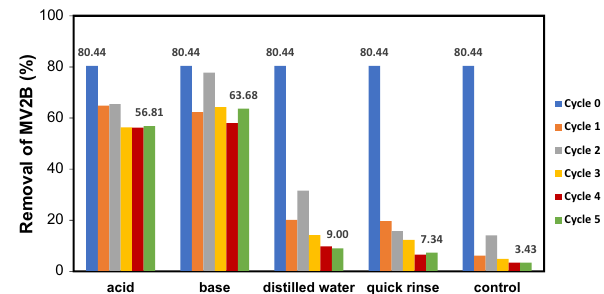
Fig. 7 Regeneration of IA through six consecutive cycles of adsorp- tion using 600 mg L −1 MV2B and desorption using acid (0.1 M HCl), base (0.1 M NaOH), distilled water, quick rinse with water and con- trol